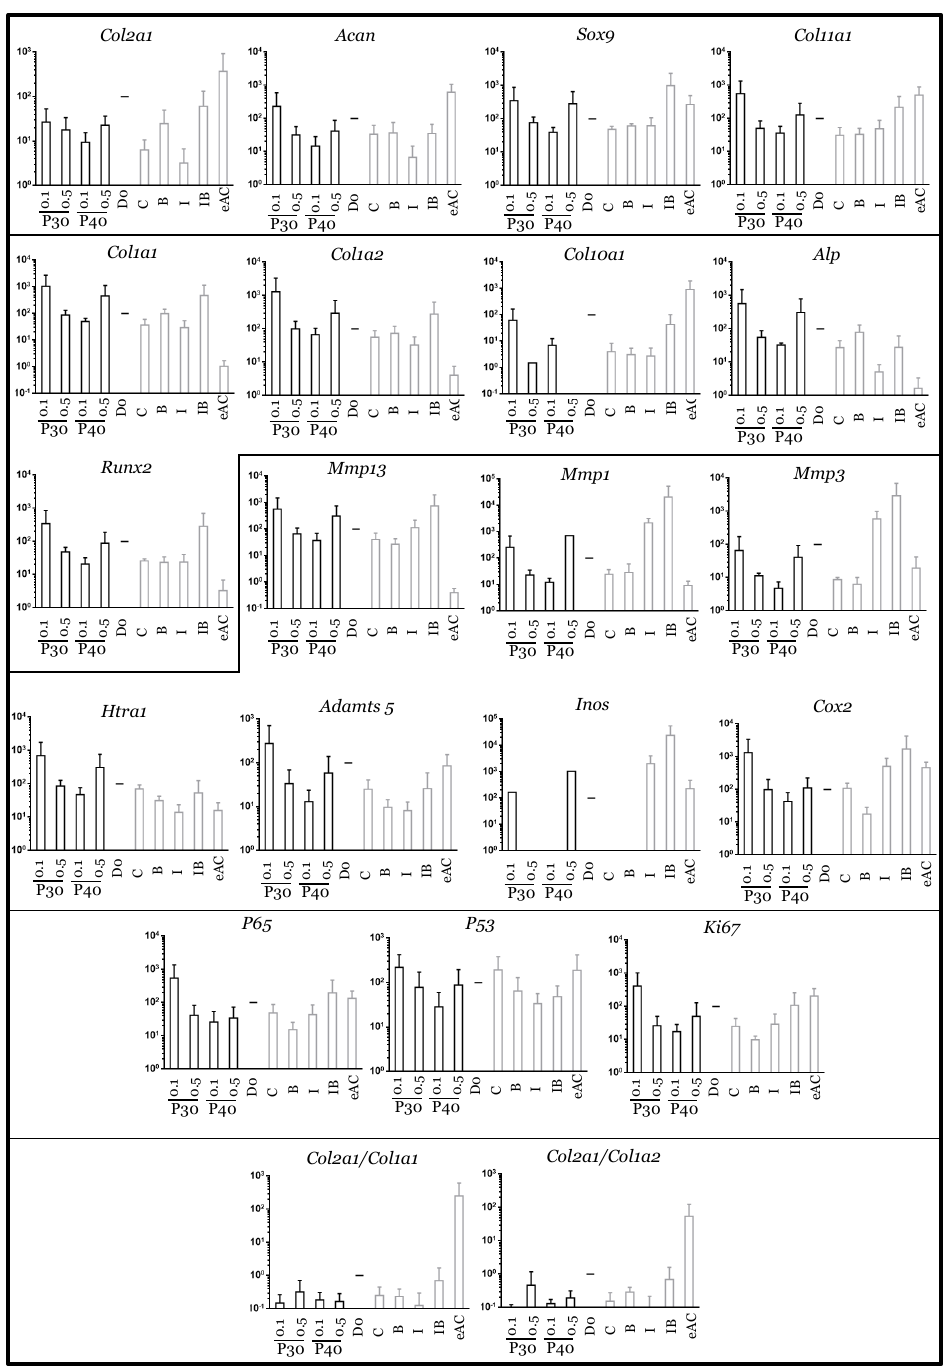
Figure 7. Comparison of mRNA expression in equine articular chondrocytes in the presence or absence of low concentrations of Promerim ® 30 and 40. Equine articular chondrocytes were grown in type I/III collagen sponges at the third passage (P3). They were incubated for 7 days in hypoxia in the absence (C: control) or presence of Promerim ® 30 or Promerim ® 40 (P30 and P40) (0.1 and 0.5 µ g/mL), or BMP-2 (B), or IL-1 (I), or BMP-2 and IL-1 (IB). At the end of incubation period, their mRNA was extracted as described in Materials and Methods. The mRNAs were estimated using RT-qPCR after normalization with respect to the β -actin reference gene. Transcript expression is shown in arbitrary units. The Col2a1 : Col1a1 and Col2a1 : Col1a2 ratios are given. The results are shown as histograms and the significance of the values between the different treatments and the control (C) was tested using a Mann–Whitney test; n = 3. eAC: mRNA extracts obtained from equine articular chondrocytes released from cartilage after overnight enzymatic digestion were used as controls. D0: cells seeded in sponges and arrested after 16 h of